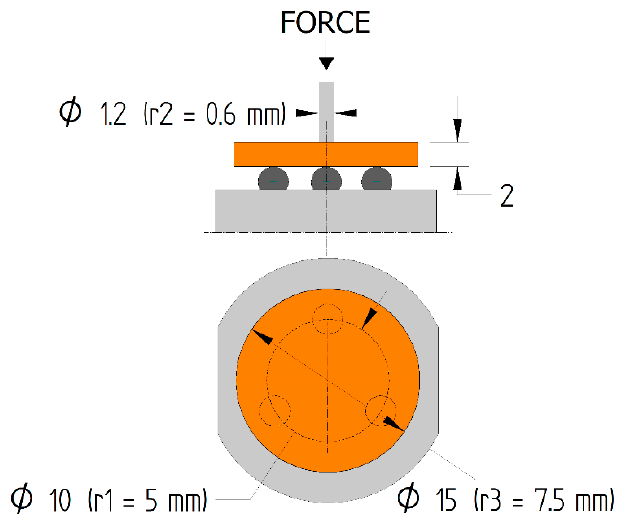
Figure 3. Schematics of the location of the specimen in the BFS test—front and top views (values are given in millimeters).